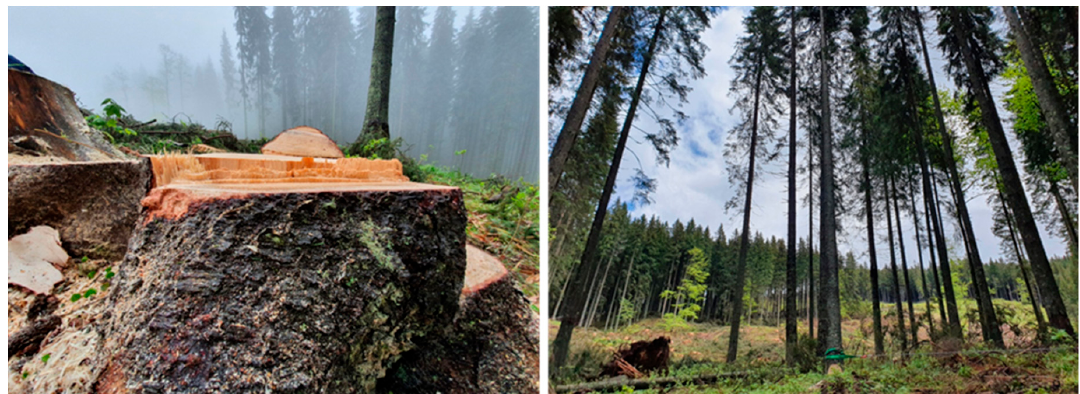
Figure 2. Working conditions (alternation of foggy, rainy, and clear sky periods).